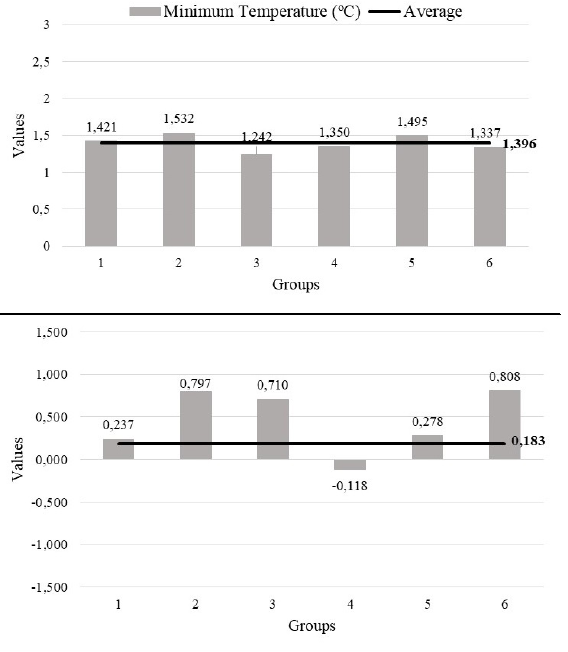
Figure 4. RMSE (a) and MB (b) values for the study area - precipitation